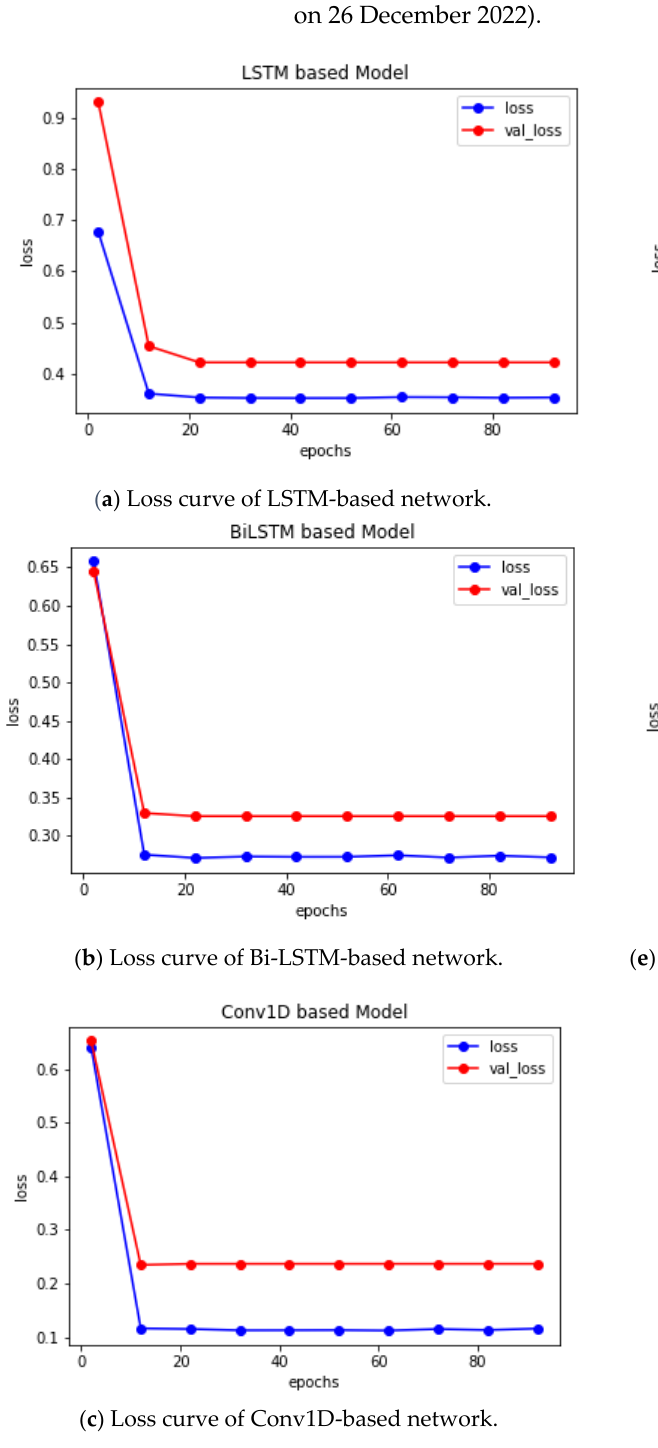
Table 6. Comparison among the experimental results.